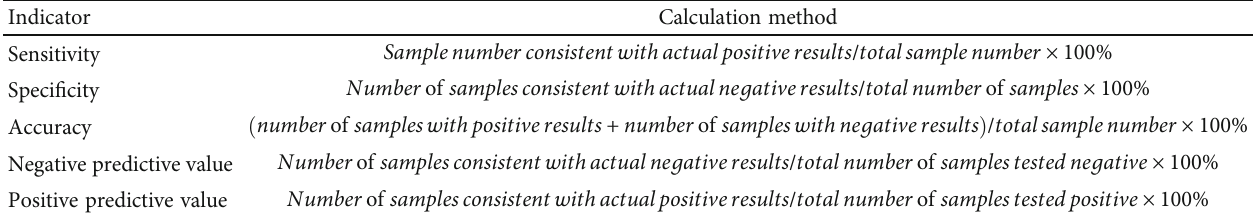
Table 1: Calculation method of diagnostic e ff ect evaluation indicators.